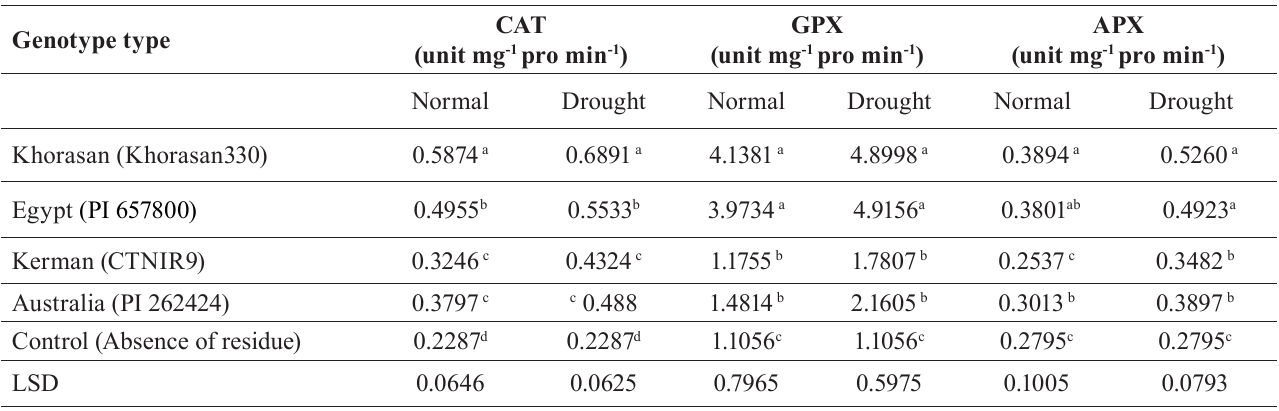
In each column, means which have similar letters do not have significant difference based on LSD test. Values are